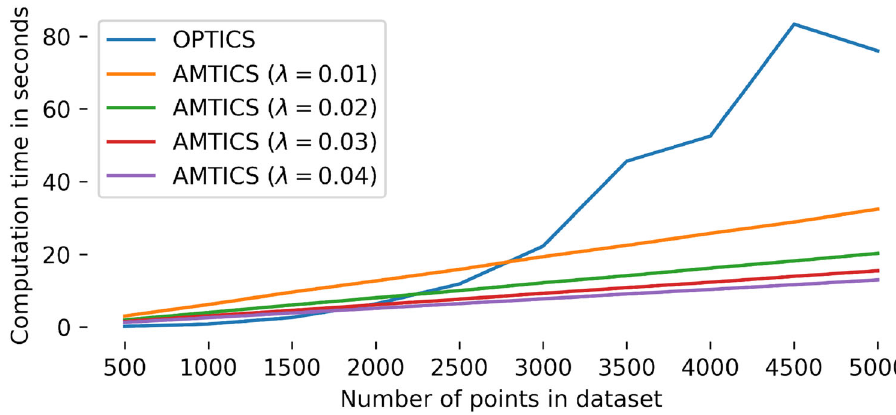
Fig. 7 Comparison of computation time for OPTICS and different AMTICS instances with varying decay factors. While OPTICS has a quadratic complexity, AMTICS shows its linear growth for increasing numbers of data